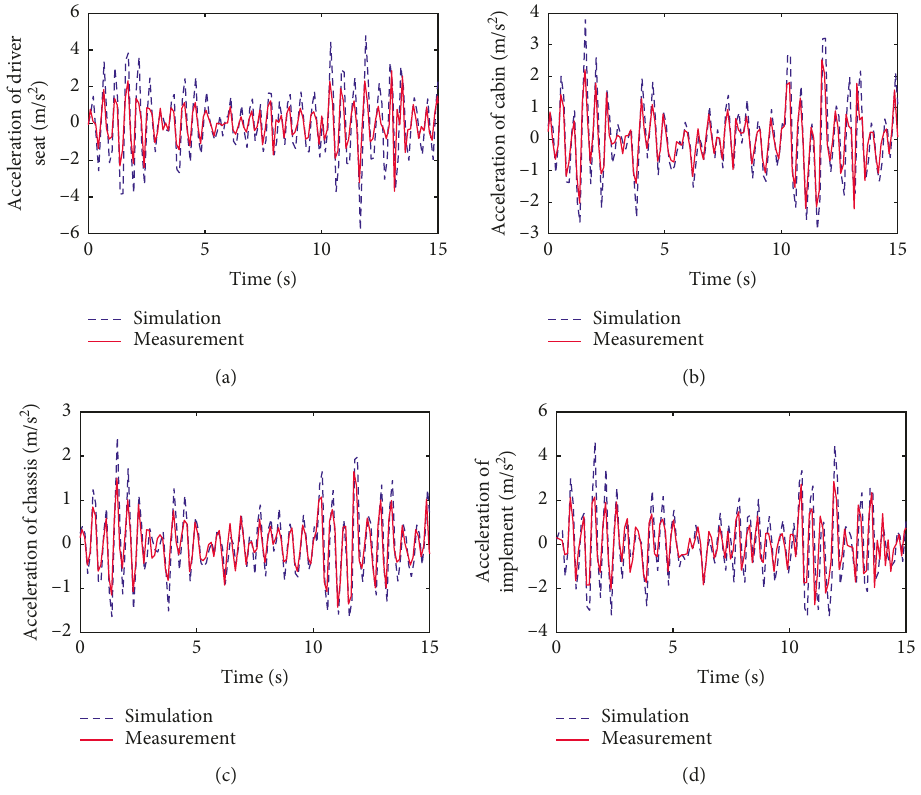
Figure 10: Vibration acceleration of the tractor/implement system: (a) driver seat; (b) cabin; (c) chassis; (d) implement.